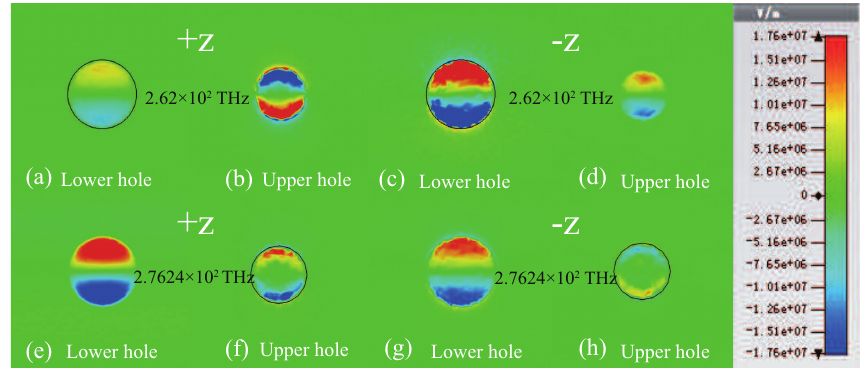
Figure 3. (Color online) z-component distributions of electric field of the two gold resonators at 262 THz ( a – d ) and 276.24 THz ( e – h ) when distance s = 275 nm in +z and − z directions,